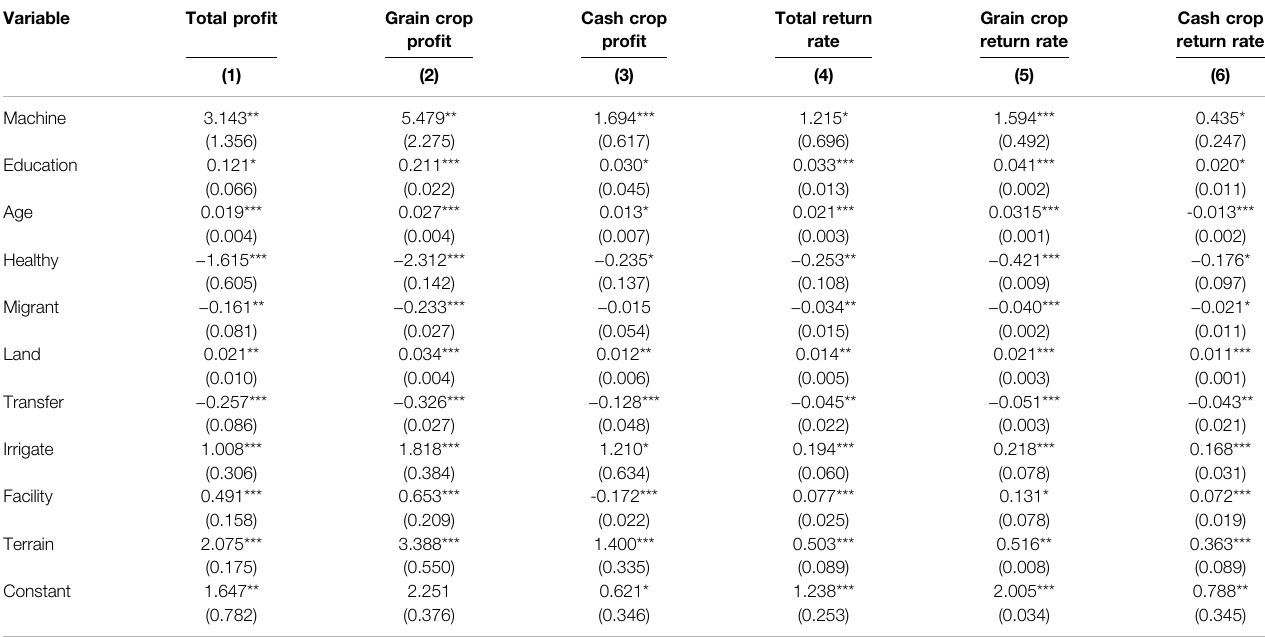
TABLE 5 | IVTobit estimation of the impact of agricultural mechanization on agricultural pro fi t and rate of return.